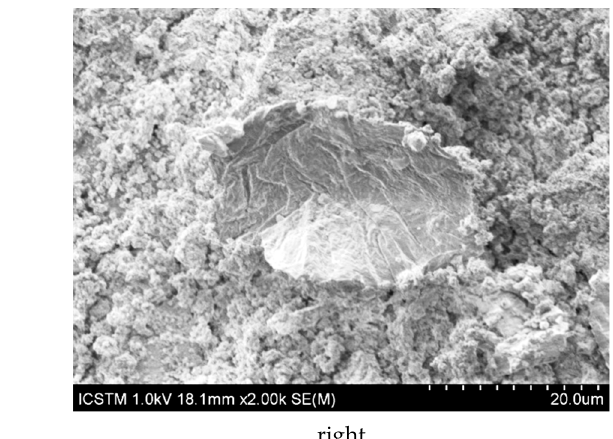
Figure 6. The SEM images for the area with gypsum ( left ) and with waxes ( right ).